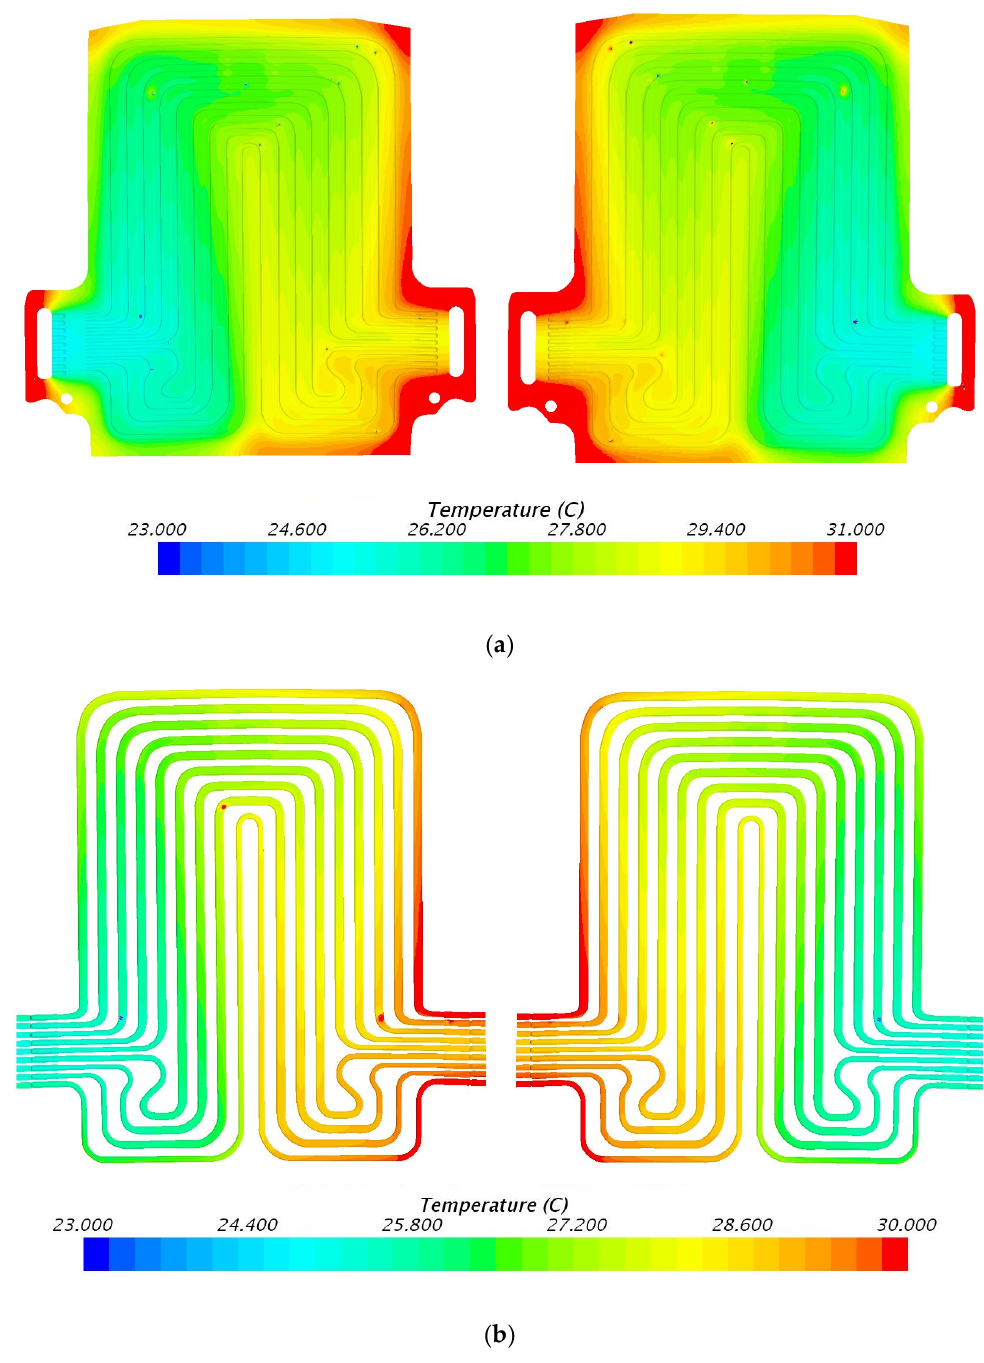
Figure 13. Temperature profile at 80 A and 25 ◦ C with heat flux values near cathode = 2309.3 W / m 2 , anode = 2648.2 W / m 2 , and mid surface = 611.1 W / m 2 . ( a ) Top view and ( b ) bottom view.